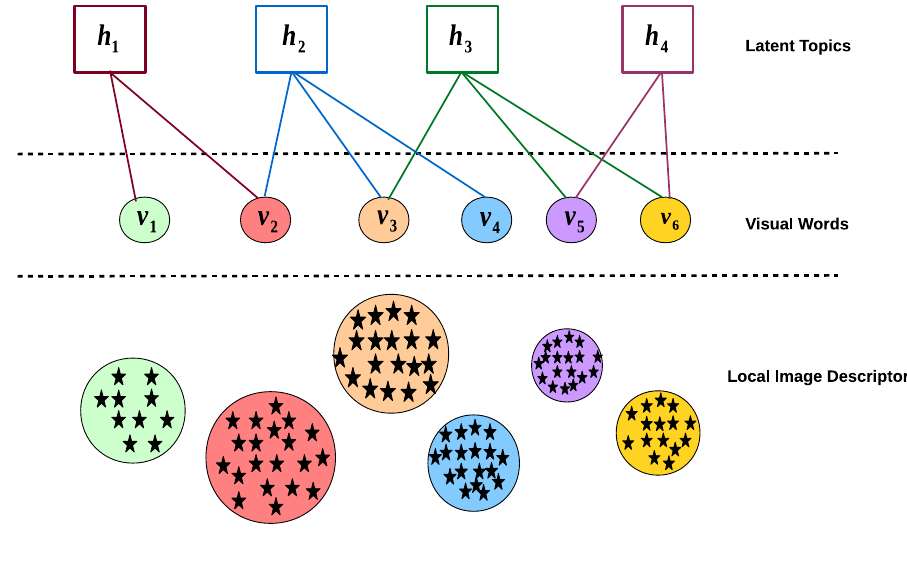
Fig. 1 Pictorial representation of the notion of visual words, latent topics and their